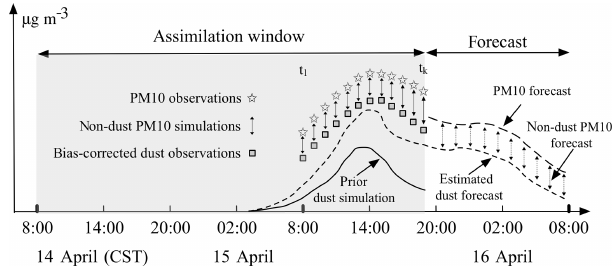
Figure 2. Timeline of observation availability, assimilation cycles, and